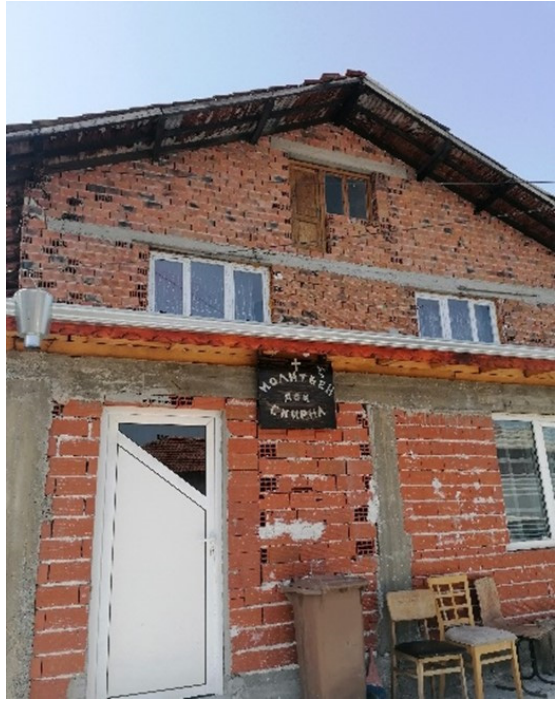
Figure 1. A Pentecostal church in a Roma neighborhood, Bansko city, 2021. Author: Mila